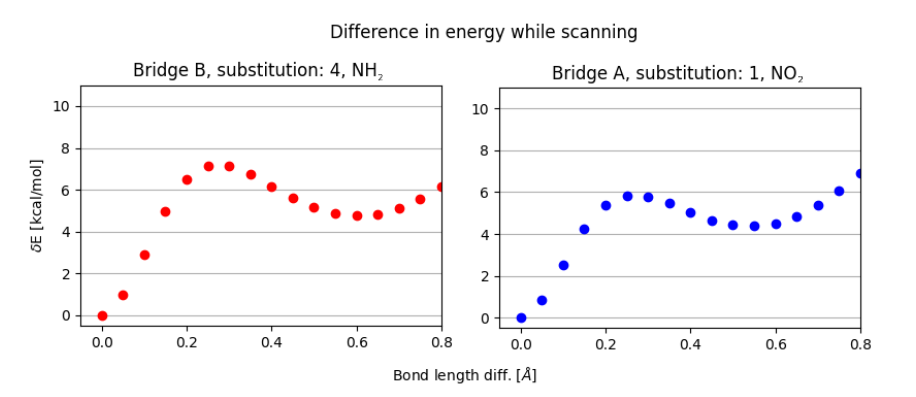
Figure 2. Illustrative energy profiles for scanning of the hydrogen bridge with proximal substitution: NH 2 , 4 ( left ) and NO 2 , 1 ( right